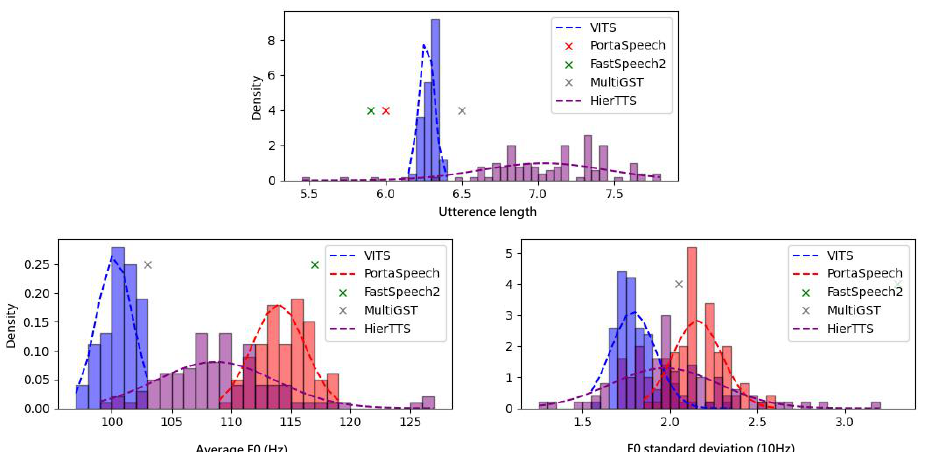
Figure 4. Example histograms of utterance length, utterance average pitch, and pitch standard deviation within an utterance. One-hundred samples were generated from each model.